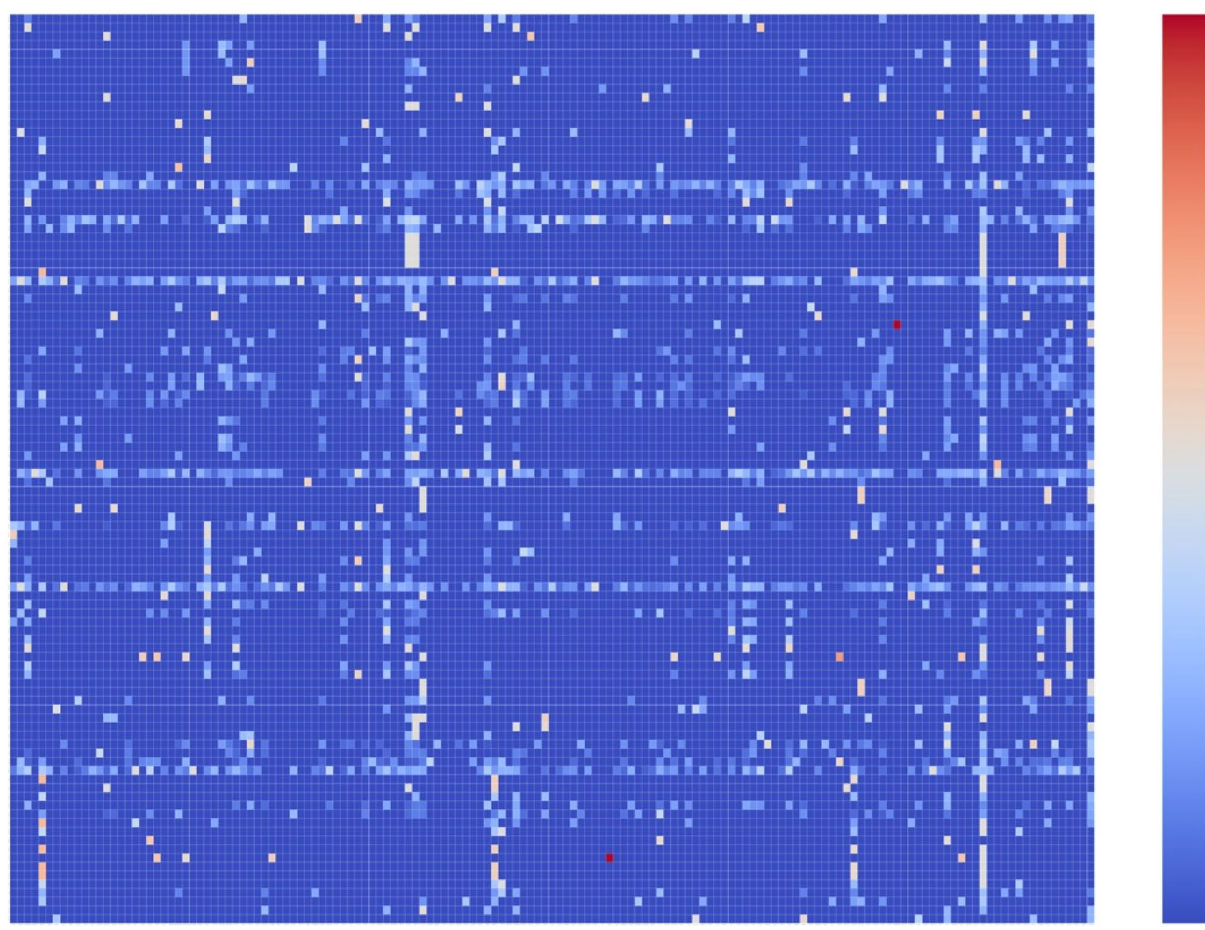
Figure 8. Heatmap representation of the odor note-olfactory receptor pairwise score for a set of 383 compounds targeting olfactory receptors and related to odor notes. The ORs are represented on the X-axis and the odor notes on the Y-axis. A red dot represents a high odor note-olfactory receptor pairwise score and a dark blue dot, no odor note-olfactory receptor relationship. The heatmap was developed with the python package seaborn (v.0.11.2): https:// seabo rn. pydata. org/ 63–65